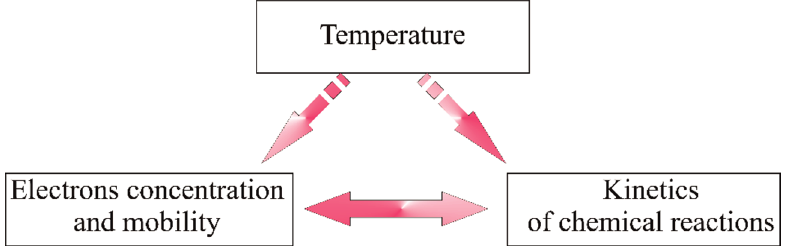
Figure 16. Impact of temperature on the physicochemical parameters of a sensor